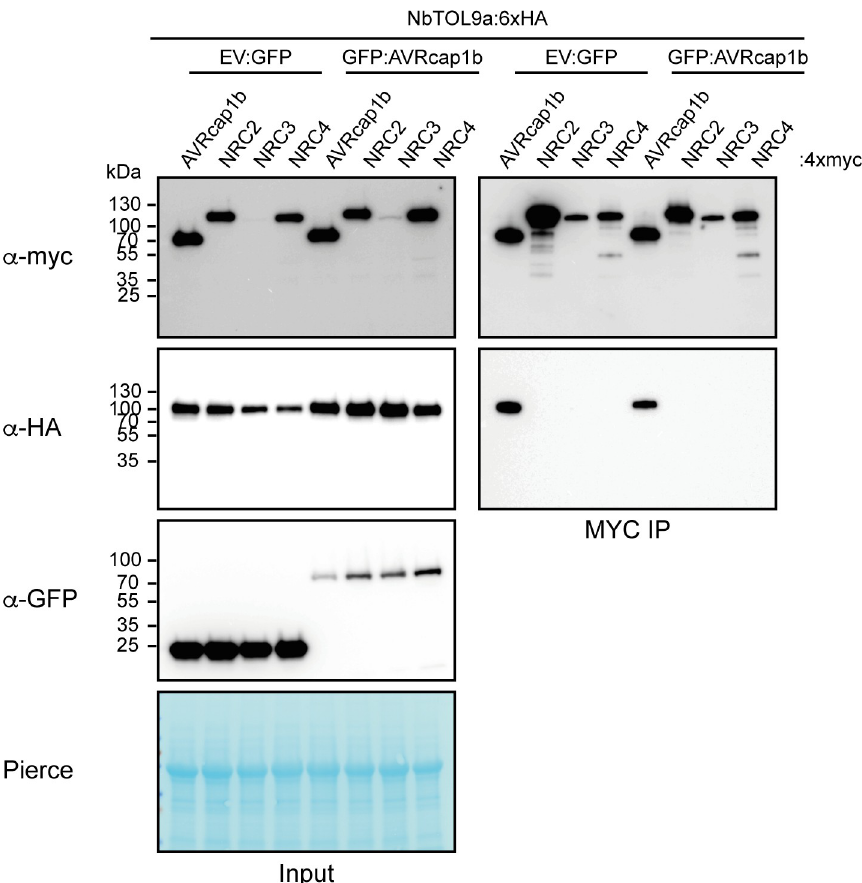
Fig 13. NbTOL9a does not associate with NRCs in planta . CoIP experiment between NbTOL9a and NRCs in the presence and absence of AVRcap1b. C-terminally 6xHA-tagged NbTOL9a was transiently coexpressed with NRC2, NRC3, and NRC4 proteins fused to a C-terminal 4xmyc tag in the presence of free GFP (EV:GFP) or N-terminally GFP-tagged AVRcap1b. C-terminally 4xmyc-tagged AVRcap1b was used as a positive control for association with NbTOL9a. IP was performed with agarose beads conjugated to MYC (MYC-IP) antibodies. Total protein extracts were immunoblotted with appropriate antisera labelled on the left. Approximate molecular weights (kDa) of the proteins are shown on the left. Rubisco loading controls were conducted using Pierce staining. This experiment is representative of 2 independent replicates. coIP, co-immunoprecipitation; IP, immunoprecipitation; NRC, NLR required for cell death.